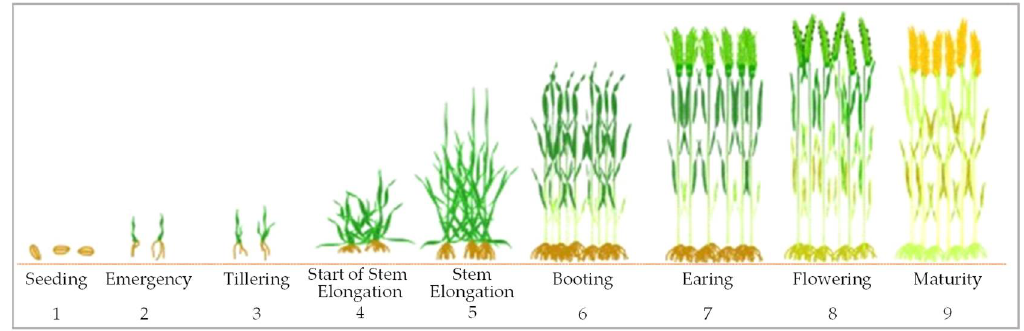
Figure 4. Phenology of wheat (https://terraevita.edagricole.it, last access 7 February 2022).